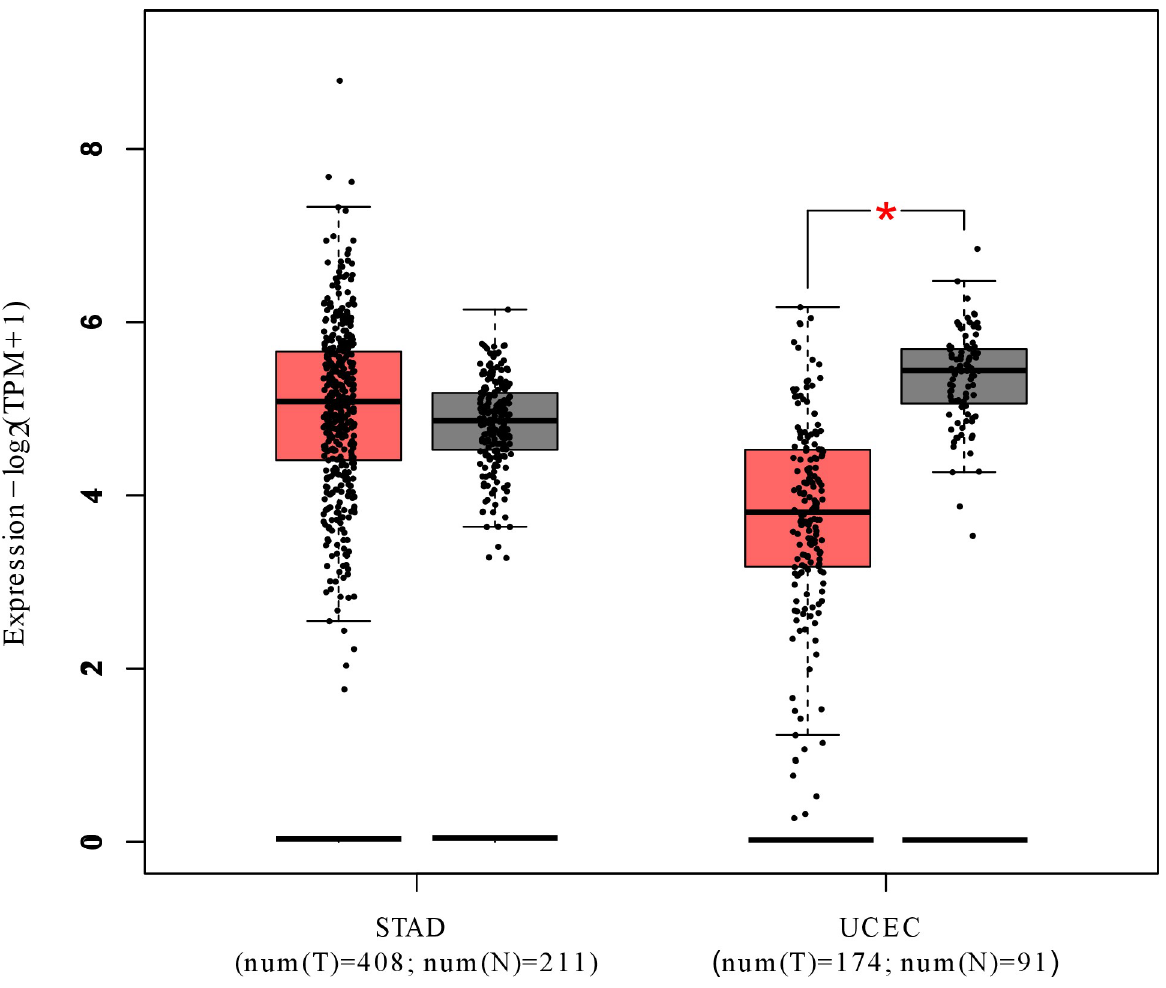
Fig 6. Box plot analysis of MTUS1 gene expression in case of STAD and UCEC for both tumor and normal samples. (Table 1) as high-risk that were predicted to be deleterious by all SNP prediction algorithms for further analysis.